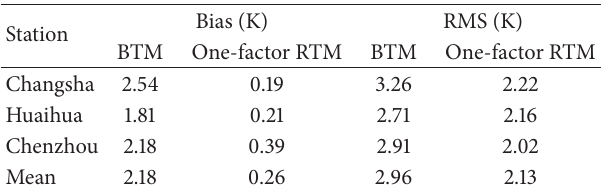
Table 2: Comparison of the biases and RMSs of 𝑇 𝑚 derived from the BTM and one-factor RTM against the 𝑇 𝑚 truth at the three